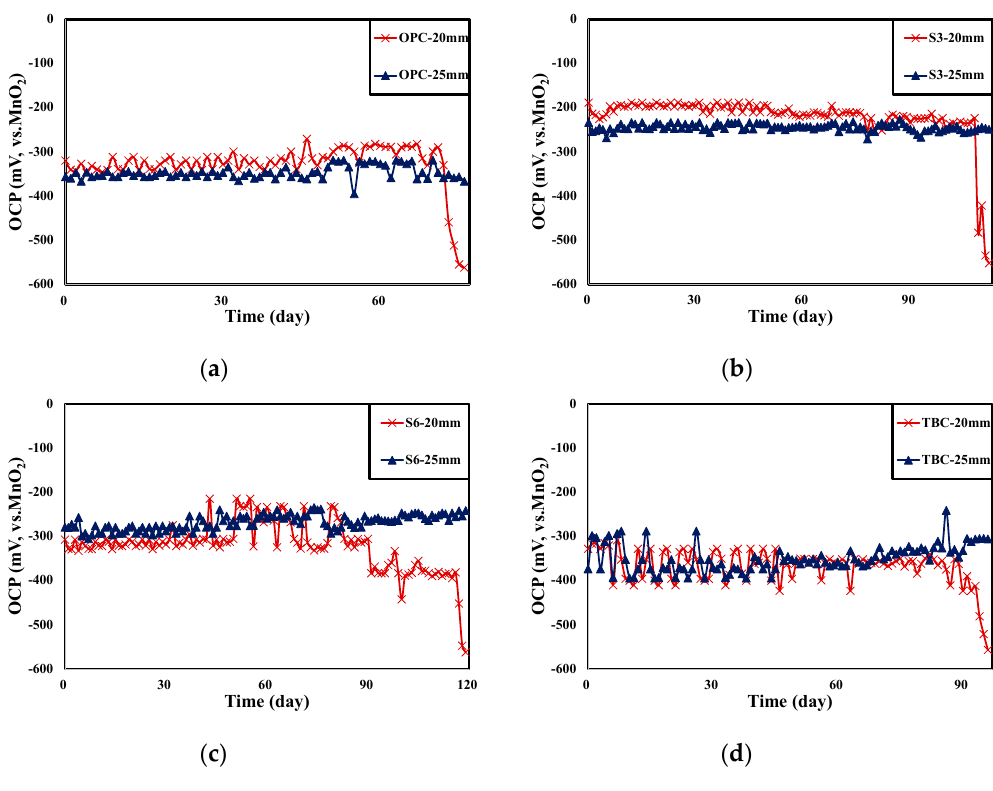
21.8 Figure 9. Chloride ion diffusion coefficient of concrete according to binder type. According to the measurement results, the chloride ion diffusion coefficient of concrete can be ranked in the order of OPC > S3 > TBC > S6, and replacing OPC with GGBFS or FA was shown to be effective in reducing the number of ions penetrating the concrete. However, when replacing GGBFS 40% + FA 20%, the chloride ion diffusion coefficient was not significantly different from the GGBFS 30% specimen even though the replacement rate was 60%. This is because the latent hydraulic property of GGBFS and the pozzolanic reaction of FA did not occur sufficiently due to the decrease in the absolute quantity of cement and the hydration products under the high admixture replacement rate and air curing conditions, so the structure of the cement matrix was not completed properly [6–20]. As a result, the compressive strength of concrete decreased, along with the resistance to chloride penetration. For this reason, concrete pore structure analysis and micro-analysis should be performed in the future in addition to analyses according to the curing conditions and period.